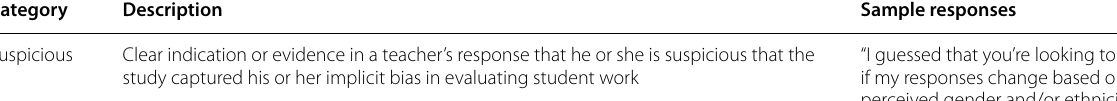
Table 3 Description of suspicion check codes and sample responses Category Description Sample responses